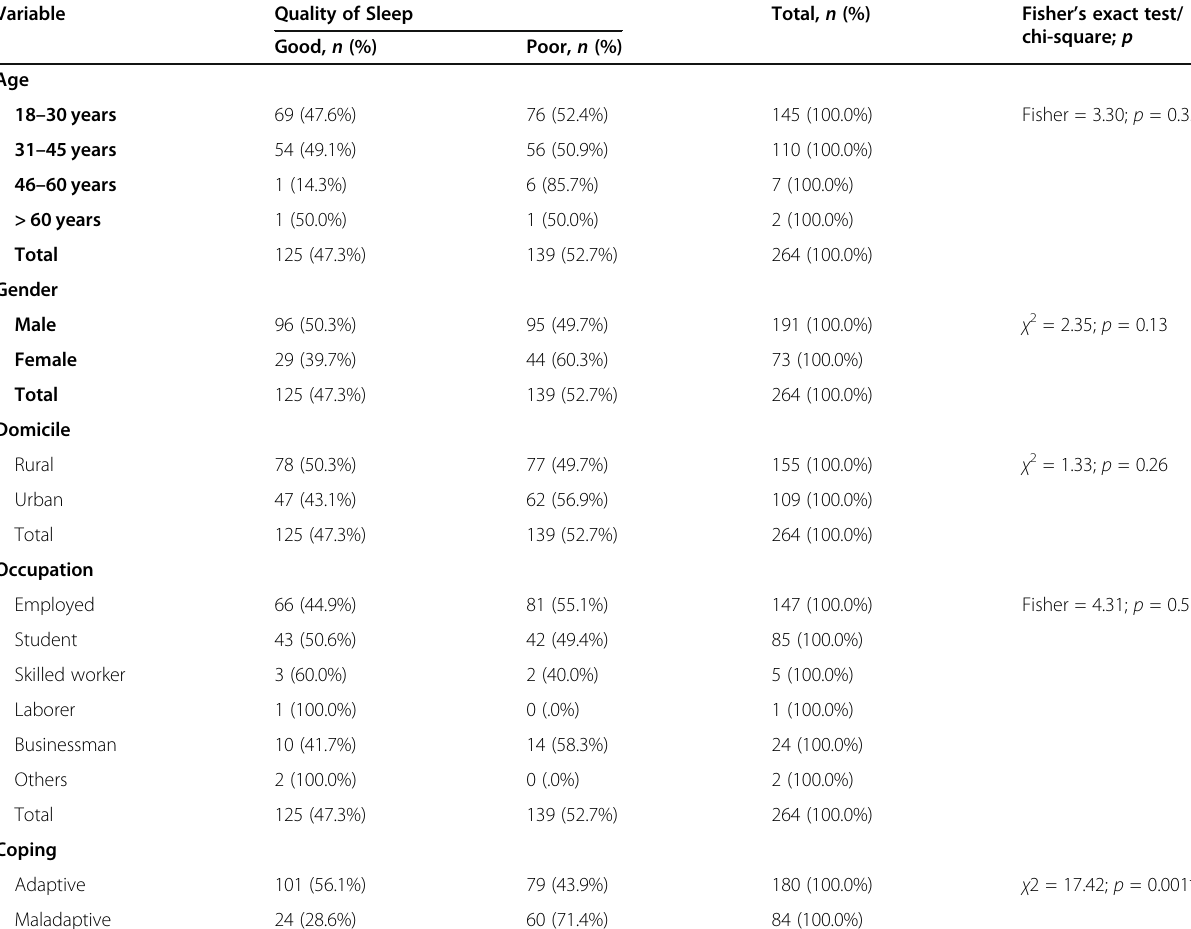
Table 4 Socio-demographic variables in relation to quality of sleep ( N = 264) Variable Quality of